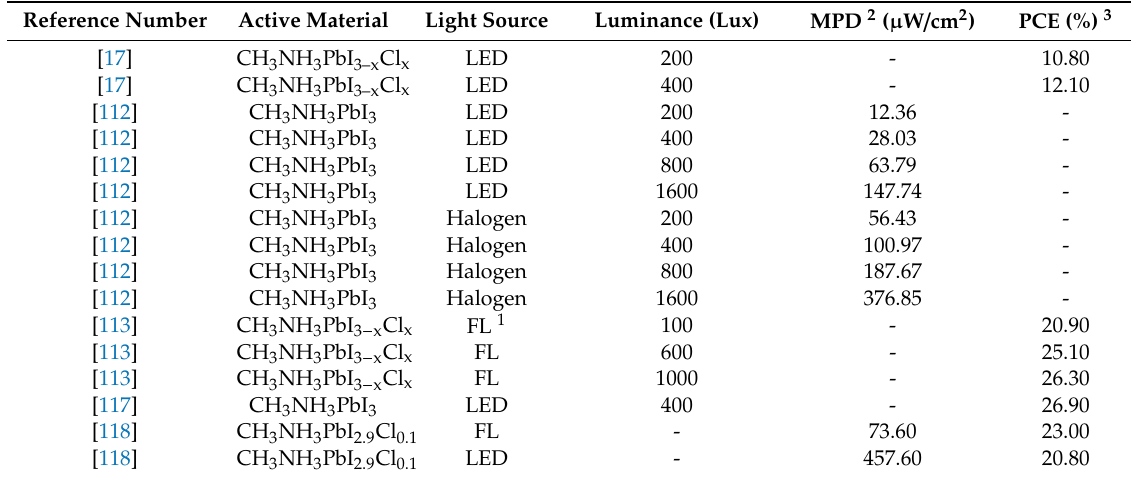
Table 4. Summary of previously reported studies on di ff erent PVSCs for indoor